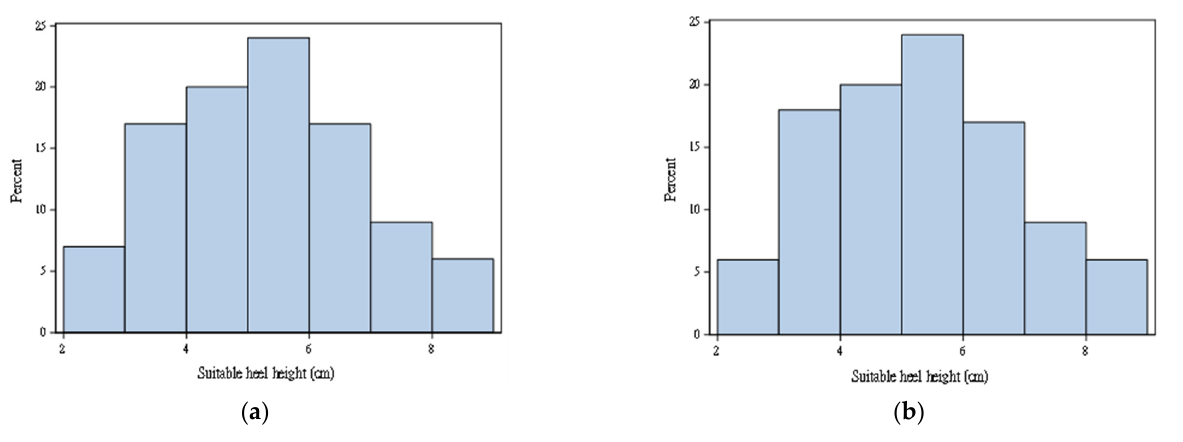
Figure 3. ( a ) Maximal observed safe heel height for ( a ) right foot; ( b ) left foot.